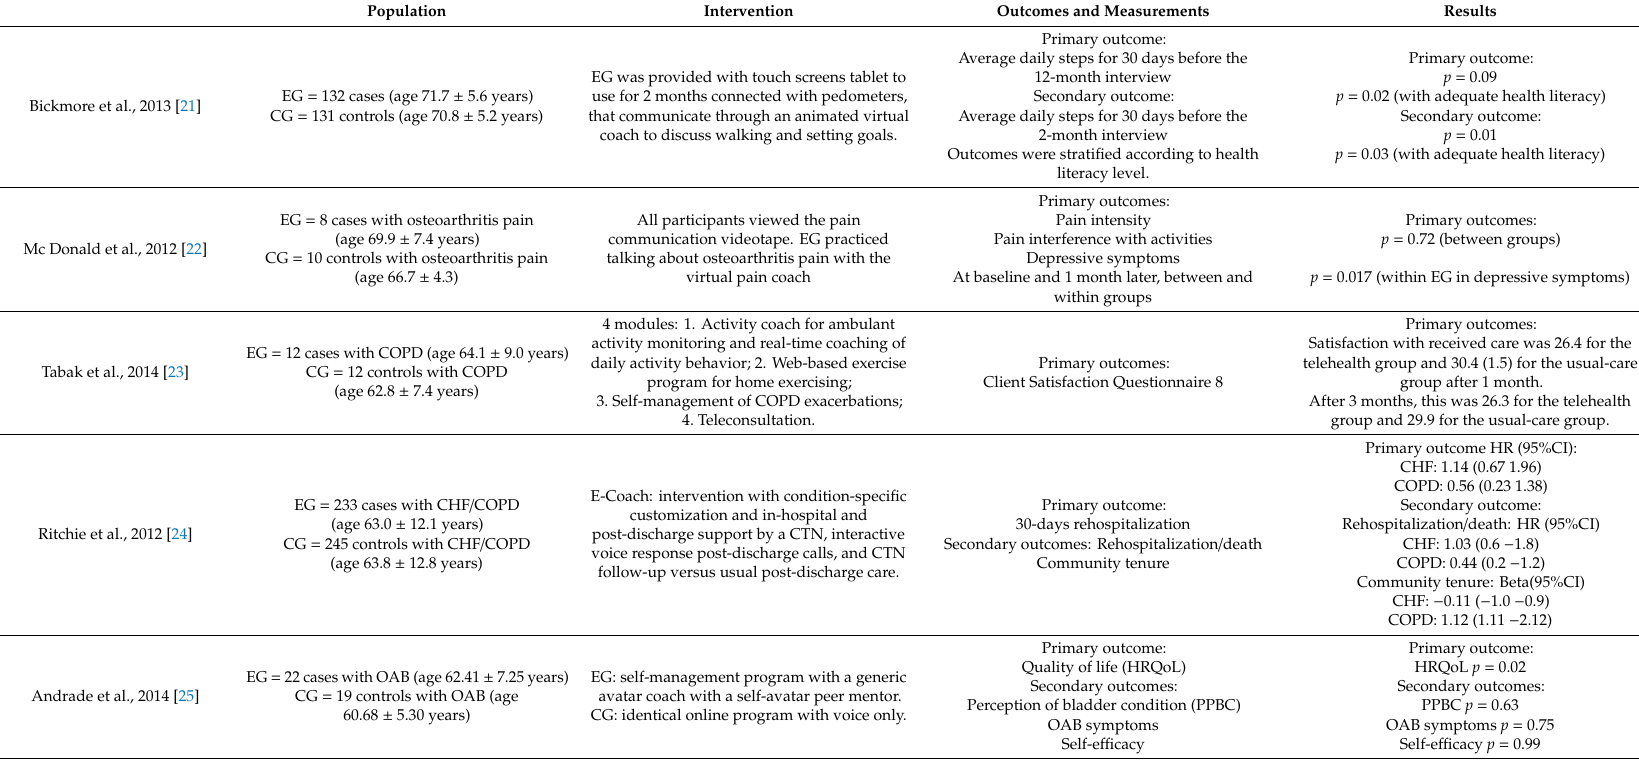
Table 2. Descriptive analysis of the included clinical studies.